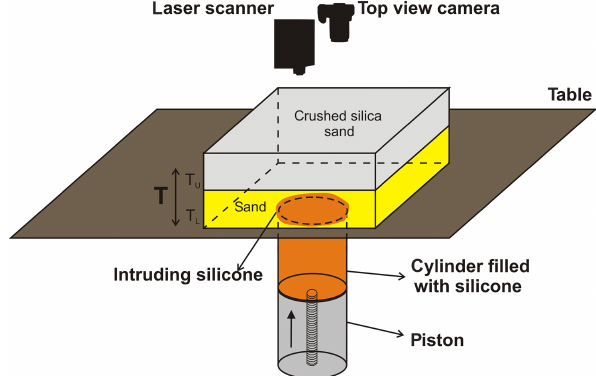
Figure 3. Experimental set-up. A motor-controlled piston pushes the silicone upward at a fixed rate (2mmh − 1 ) from the base of the layered sand pack (the diameter of the silicone is 8cm). A laser scanner and a camera record the surface deformation induced by the intruding silicone. T : total overburden thickness. T u : upper layer thickness, T l : lower layer